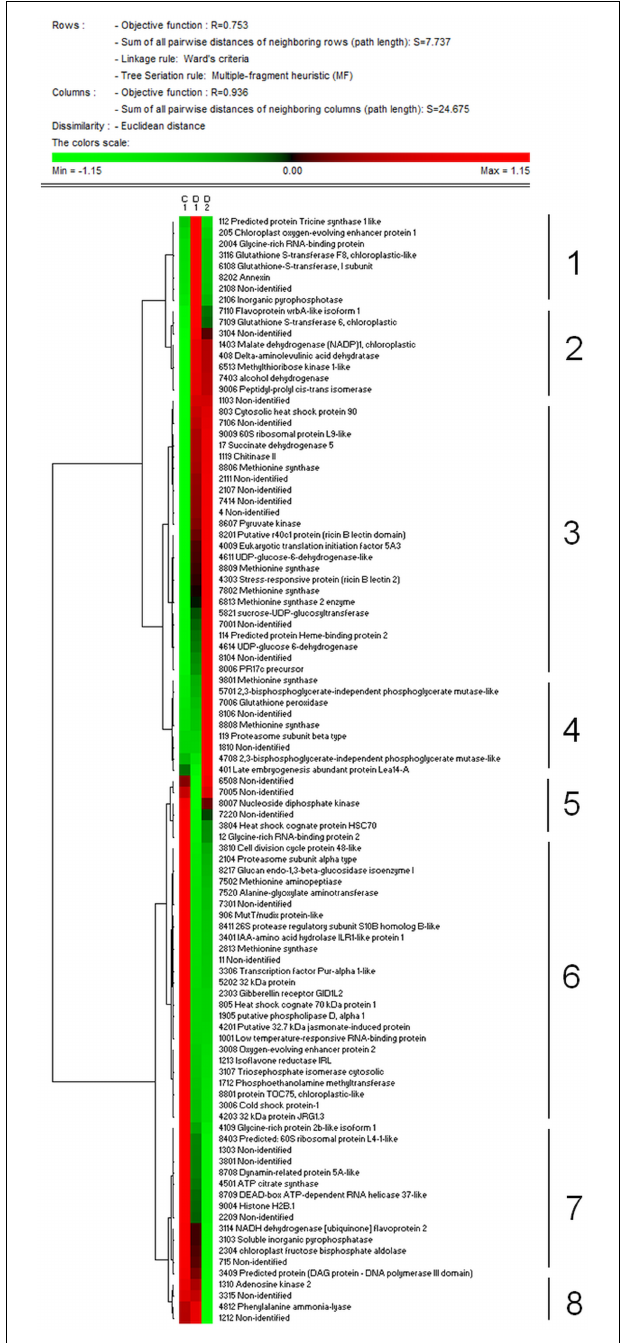
FIGURE 3 | Results of cluster analysis of 99 protein spots selected for protein identification. Cluster analysis shows patterns of protein spot relative abundance in samples grown under control (C), drought 1 (D1) and drought 2 (D2) conditions. Euclidean distance and Ward’s minimum criteria were applied for the